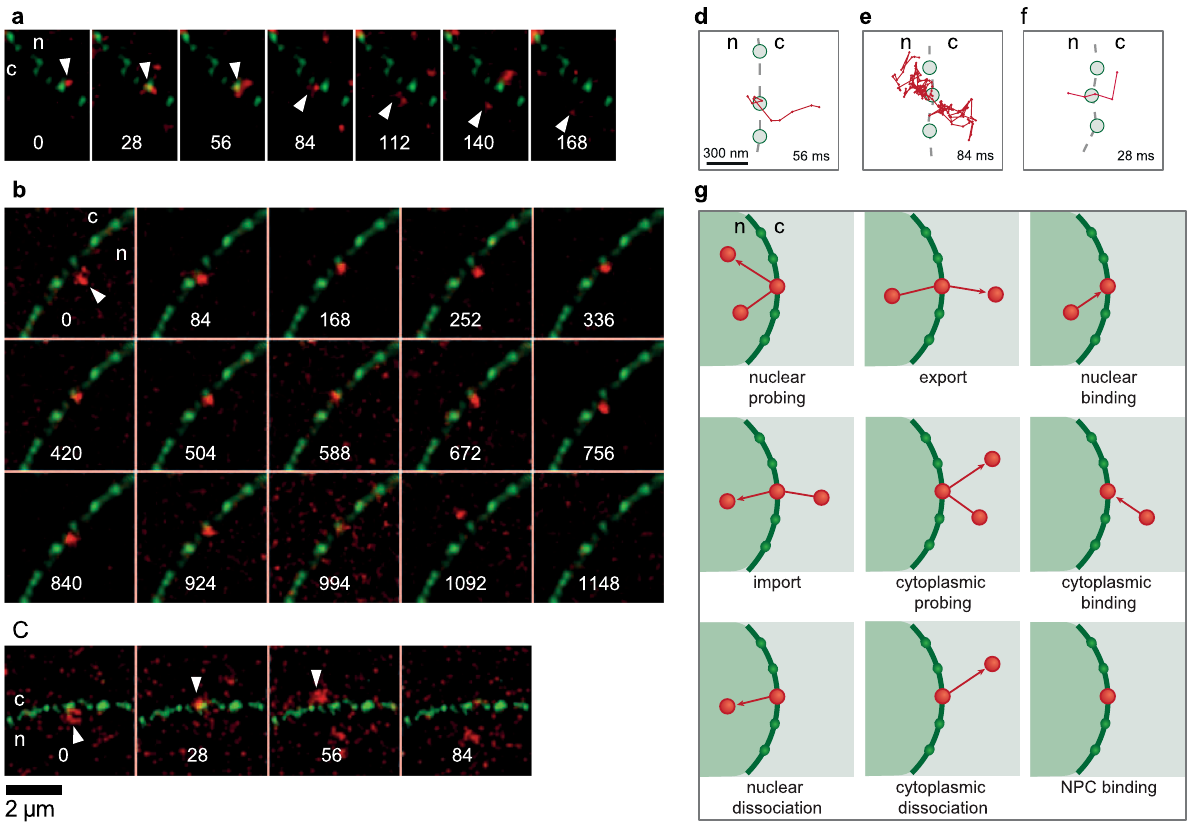
Fig. 3 Single pre-60S particles (red) passing a single NPC (green). a – c Image sequences showing export events. The numbers represent time in ms. d – f